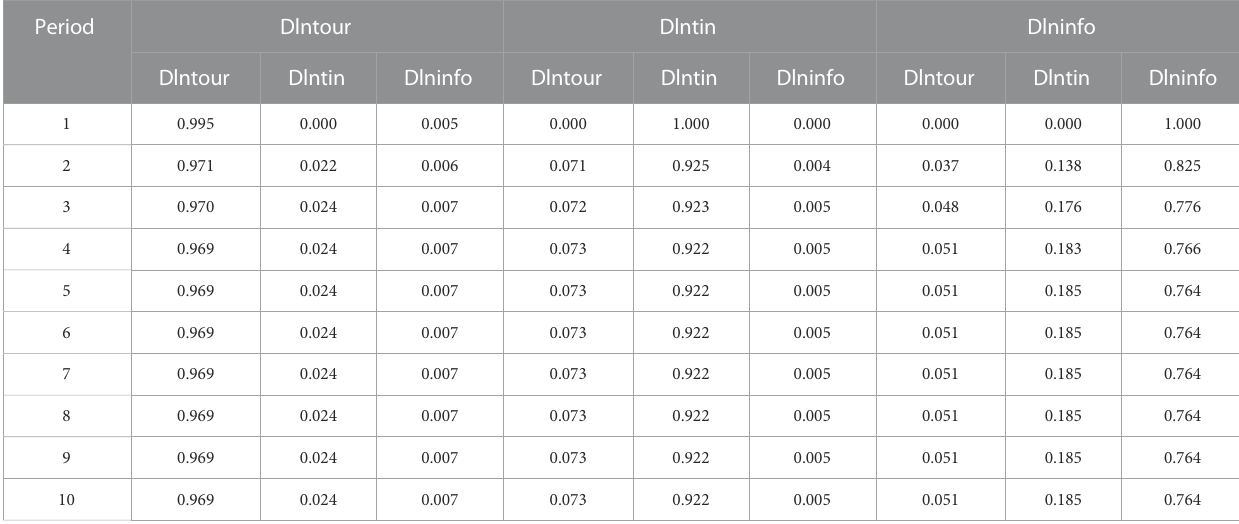
TABLE 7 Variance decomposition results.